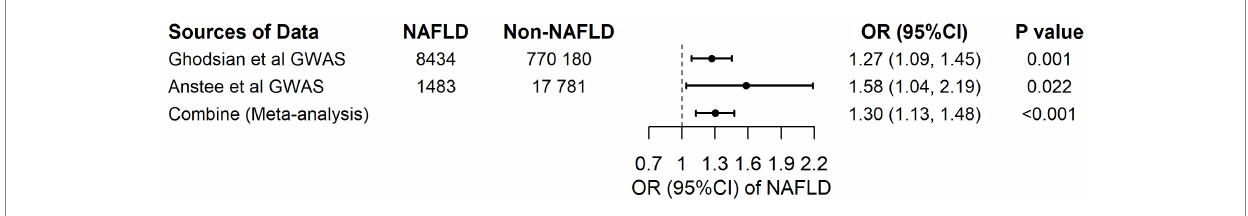
FIGURE 2 Association between genetically predicted Vitamin B12 and NAFLD. Vitamin B12, serum Vitamin B12; GWAS, genome-wide association studies; OR, odds ratio; NAFLD, non-alcoholic fatty liver disease.